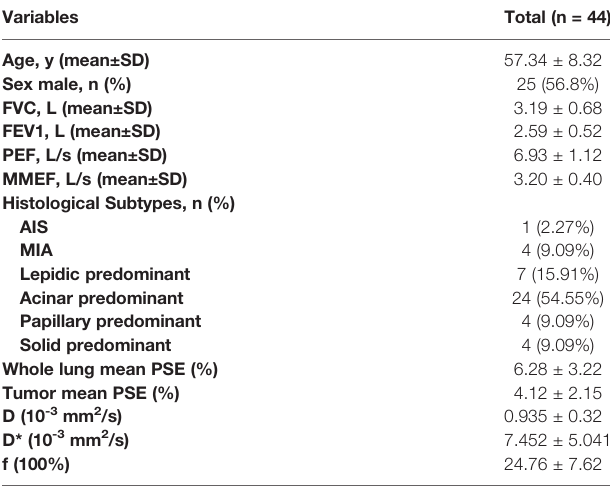
TABLE 1 | Summary of the demographic and clinical features of the patients.